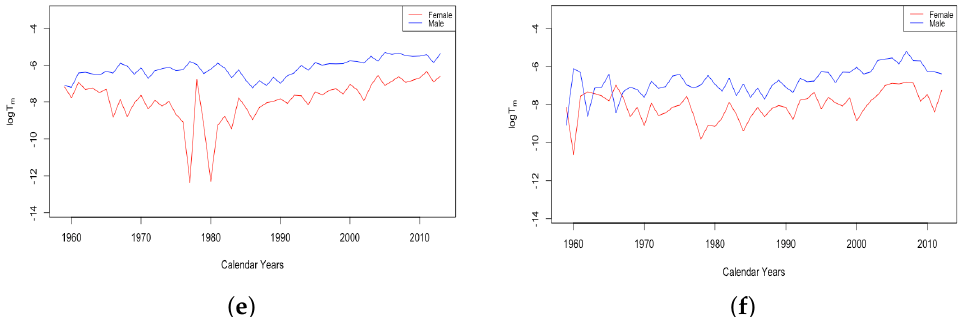
Figure 17. ( a ) The log of limiting teenage mortality T m in France. ( b ) The log of limiting teenage mortality T m in Japan. ( c ) The log of limiting teenage mortality T m in Switzerland. ( d ) The log of limiting teenage mortality T m in the USA. ( e ) The log of limiting teenage mortality T m in Russia. ( f ) The log of limiting teenage mortality T m in Ukraine.